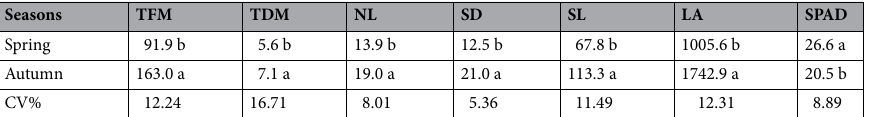
Seasons TFM TDM NL SD SL LA SPAD